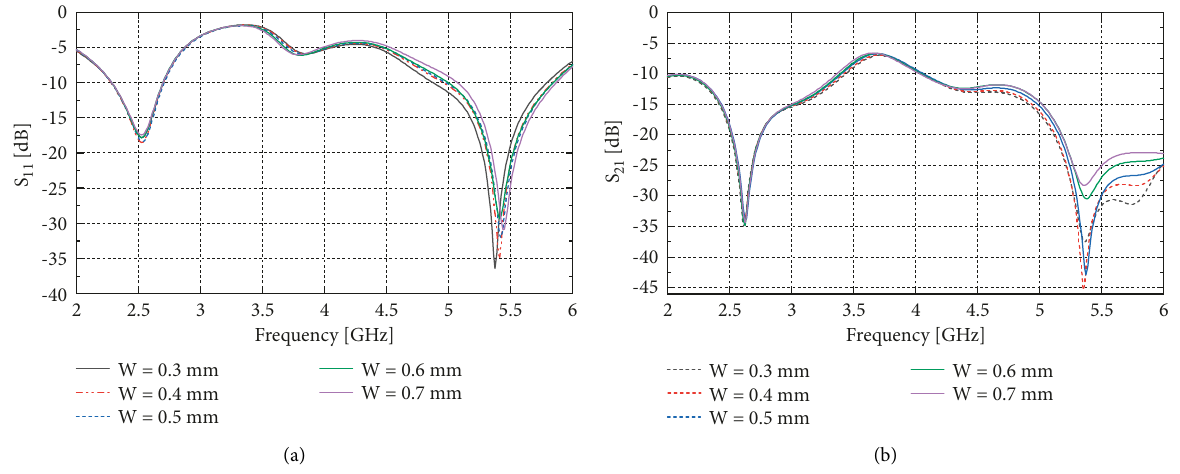
Figure 7: S-parameters of antenna#1 with different widths of the NL: (a) S